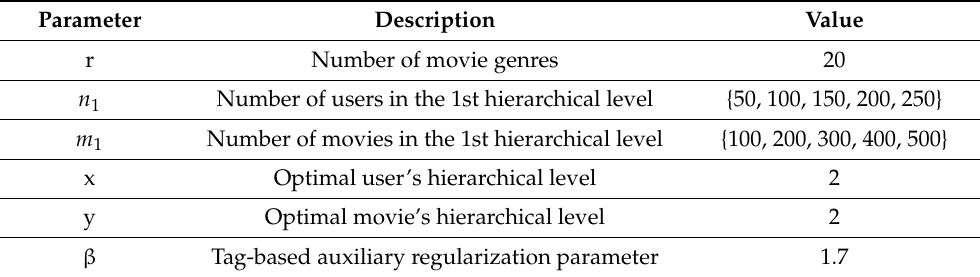
Table 1. Model parameters.